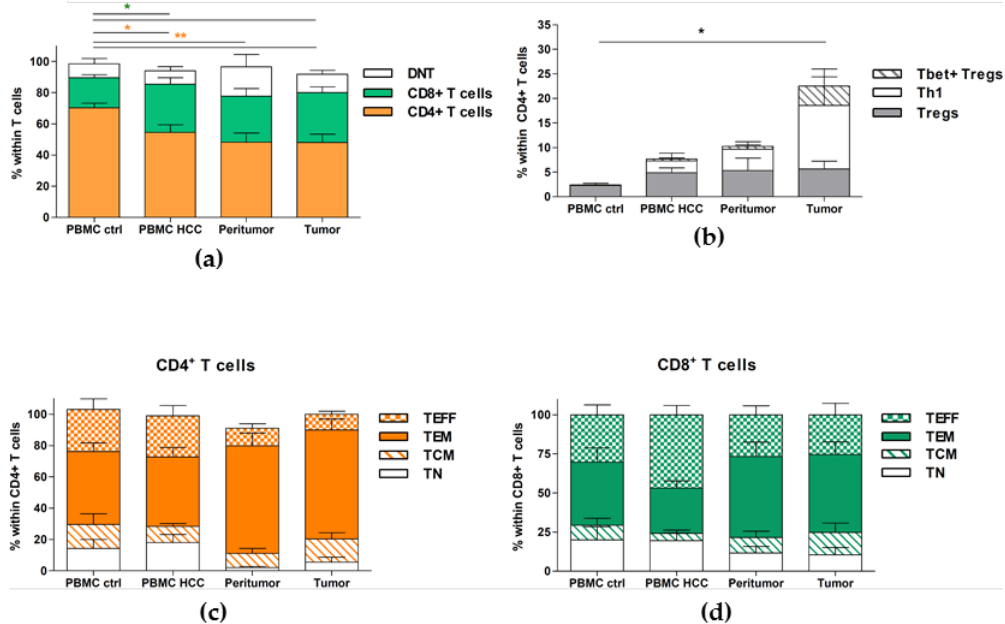
Figure 3. Tregs are increased in HCC patients while E ff ector T cells are reduced. Cell suspensions were prepared from PBMC, tumor and peritumor taken during surgery and were analyzed by flow cytometry. The PBMC from healthy donors were used as control. The frequencies of T cell subsets were analyzed in detail. ( a ) Frequencies of total CD4 + T cells, and CD8 + T cells within total CD3 + T cells are shown; ( b ) Frequencies of Tregs (CD4 + Foxp3 + T-bet − T cells), Th1 (CD4 + Foxp3 − T-bet + cells) and T-bet + Tregs (CD4 + Foxp3 + T-bet + cells) within CD4 + T cells. ( c , d ) Naïve (T N ), central memory (T CM ), e ff ector memory (T EM ) and e ff ector cell (T EFF ) subsets within CD4 + T cells and CD8 + T cells. Results are expressed as Mean ± SEM from cumulative results (with n = 9–14 patients or controls). * p < 0.05 and ** p < 0.01 as determined by Mann–Whitney’s test between each lymphoid subset, in each